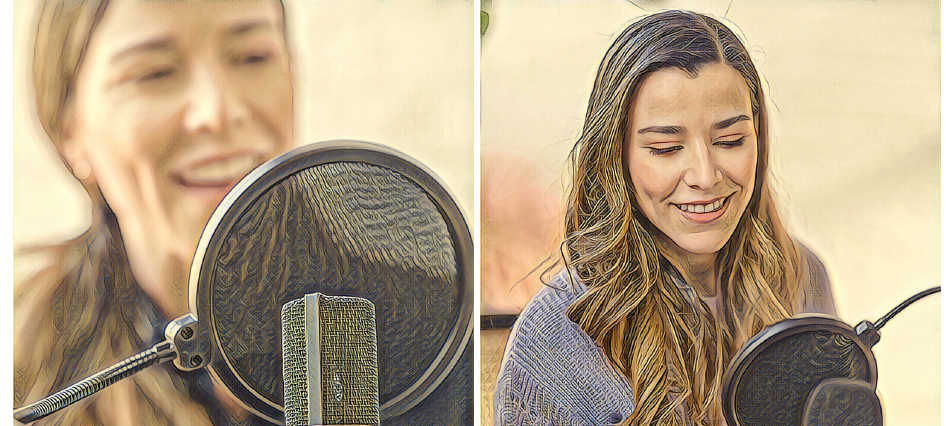
Figure 2. Illustrations of voice-based interaction styles.